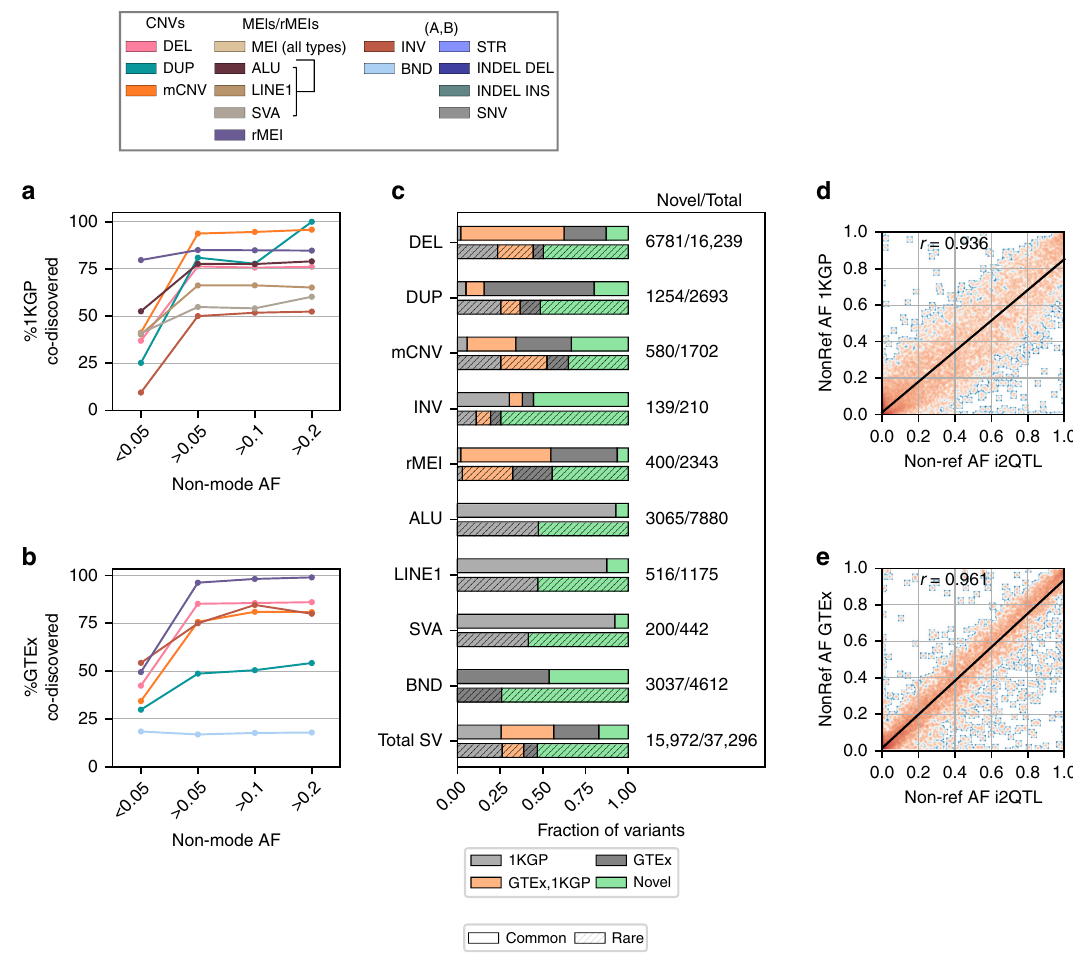
Fig. 4 Comparison to other SV calling studies. a , b The fraction of variants from either a 1KGP (European population) or b GTEx that were also captured in our study in different non-mode allele frequency (NMAF) bins. c Fraction of i2QTL SVs that were co-discovered in 1KGP, GTEx, both 1KGP and GTEx, or were unique to i2QTL (novel), divided by whether variants were common (>0.05 NMAF) or rare (<0.05 NMAF) in unrelated i2QTL samples indicated by absence or presence of hatching respectively. d , e Non-reference allele frequency of variants co-discovered in i2QTL and d 1KGP (Europeans) or e GTEx in their respective discovery samples. Here, the non-reference allele frequency among unrelated i2QTL donors is used, and the density is plotted with orange indicating more observations, and blue